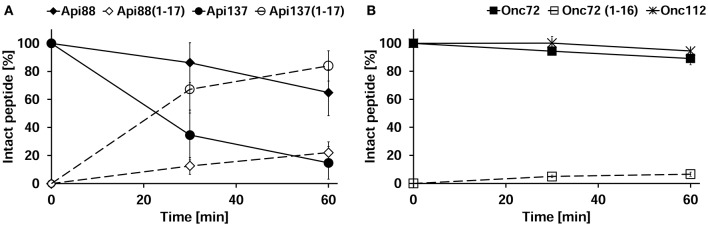
Peritoneal lavage stability of apidaecins (A) and oncocins (B). Api88 (full diamonds), Api137 (full circles), Onc72 (full squares), and Onc112 (full asterisks) were incubated in lavage ex vivo and quantified after 30 and 60 min by RP-HPLC. Shown are the quantities of the incubated peptides (full symbols) and their main metabolites Api1-17 and Onc1-16 (open symbols) normalized to the initial peptide amounts determined at 0 min. The considered monoisotopic masses of the quadruply protonated metabolites were m/z 545.5 (Api1-17) and m/z 479.5 (Onc1-16) matching very well the signals at m/z 545.6 and 479.5, respectively, recorded with an Esquire HCT ESI-Iontrap-MS.